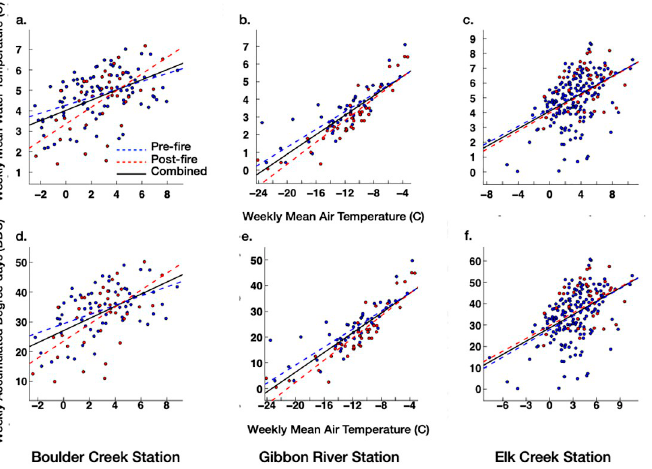
Fig 4. Pre- and post-fire regression lines for weekly winter mean air temperature (MAT)—mean water temperature (MWT) and accumulated degree-days (ADD) data for (a and d) Boulder Creek, (b and e) Gibbon River, and (c and f) Elk Creek stream sites. Red and blue filled circles represent the pre- and post-fire weekly winter MAT–MWT or ADD events, respectively.